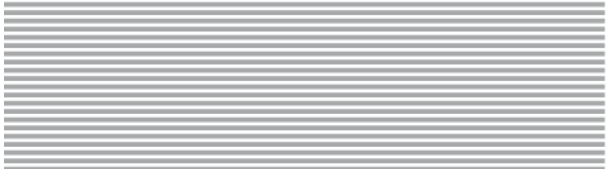
Figure 6. Template with the relative area of raster elements of 40–45%.